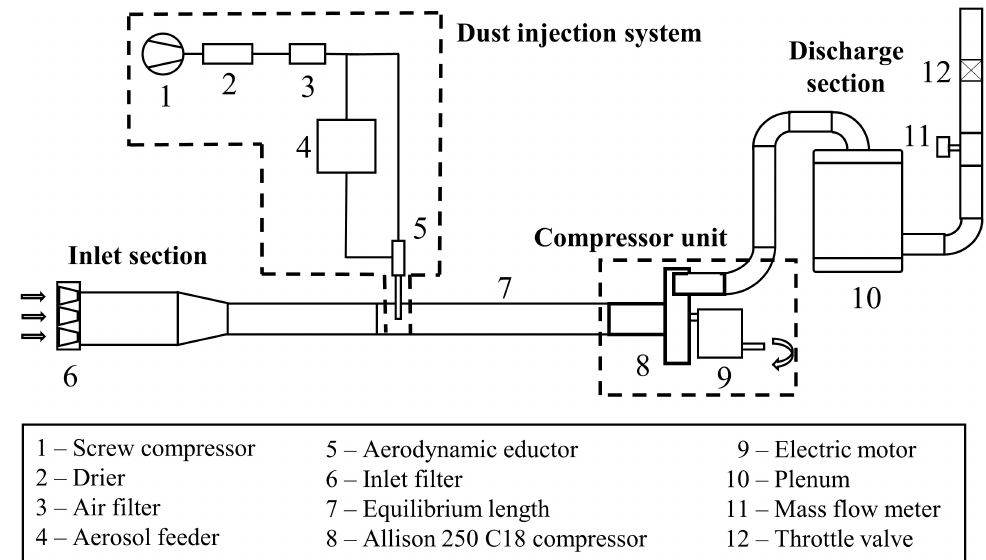
Figure 4. Schematic layout of the test